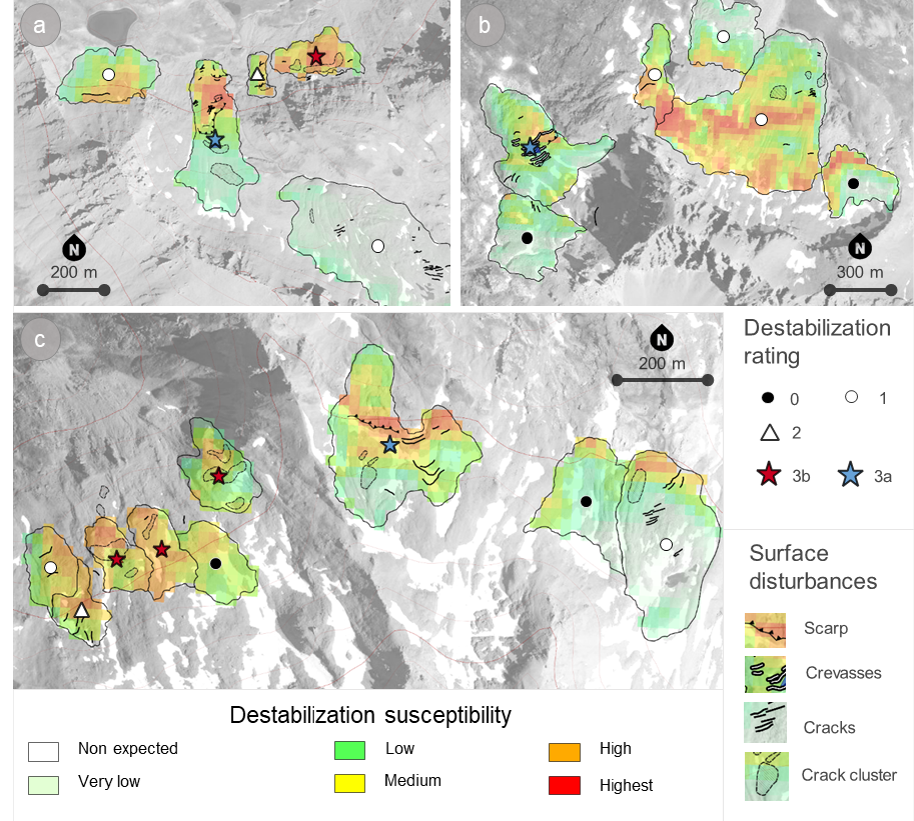
Figure 8. Examples of the susceptibility map in (a) Roc Noir, (b) Pierre Brune, and (c) Iseran and neighbouring rock glaciers. The suscepti- bility map successfully identifies instabilities observed on the potentially destabilized rock glaciers. Nevertheless, some predicted instabilities were observed in areas that appear stable by observing the